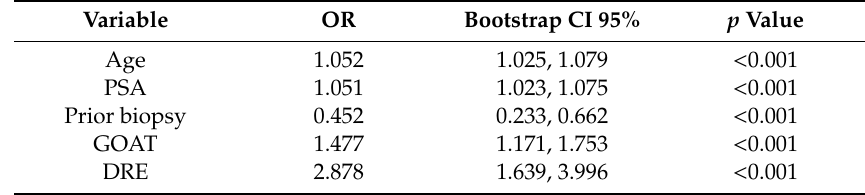
Table 3. Multivariate analysis of the association of plasma GOAT levels with the diagnosis of Significant PCa (SigPCa) in the full cohort of patients adjusting with common clinical variables. Variable OR Bootstrap CI 95% p Value Age 1.052 Prior biopsy 0.452 0.233, 0.662 < 0.001